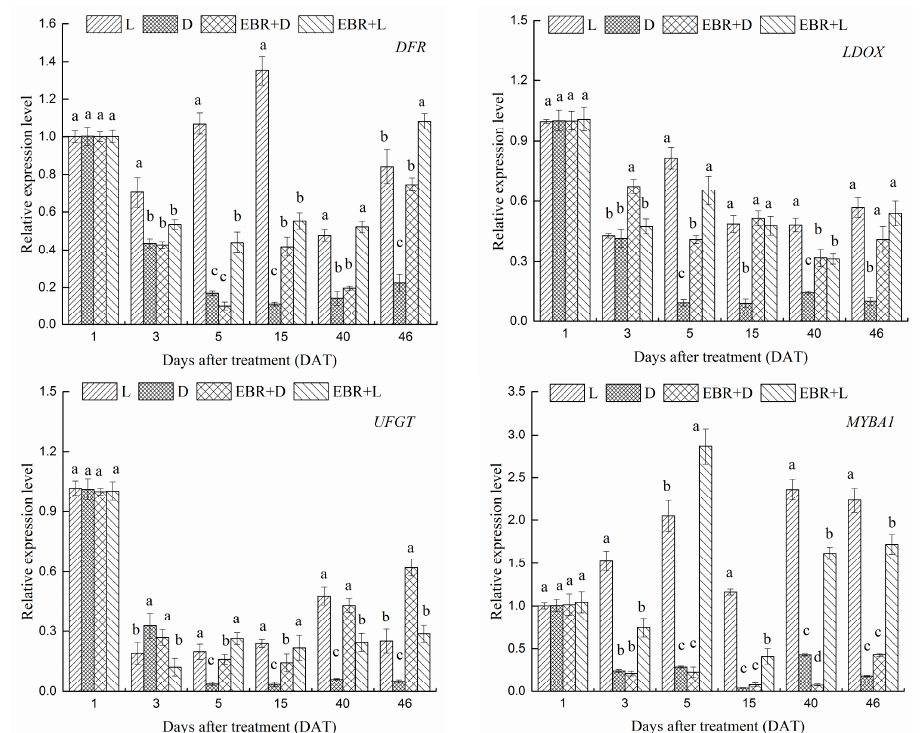
Figure 5. Transcript profiles of VvCHI1 , VvCHS2 , VvCHS3 , VvF3’5’H , VvDFR , VvLDOX , VvUFGT and VvMYBA1 as the molar ratio of the mRNA level to that of VvGAPDH in each sample (mean ± SE; n = 3). The different letters (a, b, c, d) indicate significant differences between treatments at p < 0.05 (Duncan’s multiple range test).